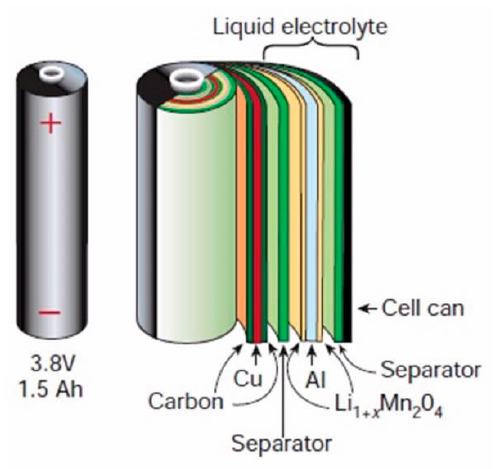
Figure 1. Cylindrical cell details ((reproduced with permission from Springer Nature Ref. [26]).